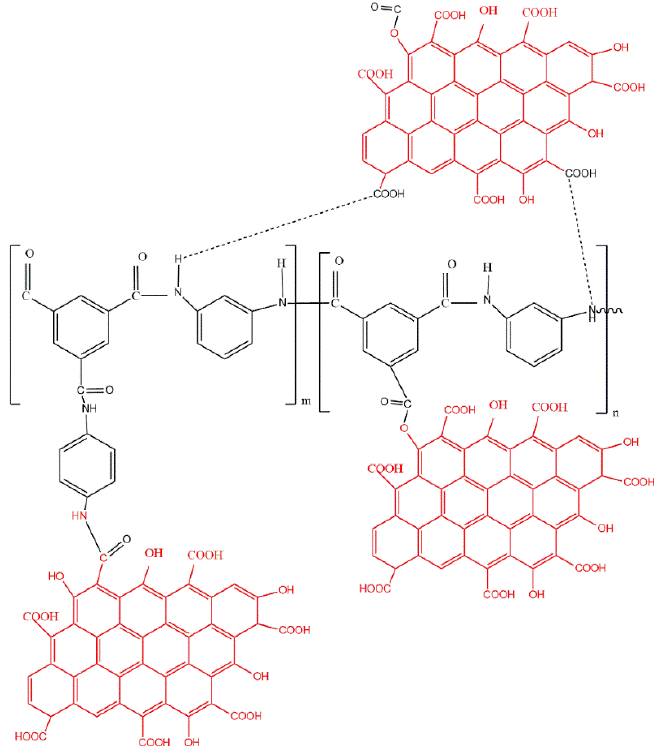
Figure 8. Interaction mechanism of PA chain and GQDs, where m and n represent the crosslinked and the linear fractions of the PA framework, respectively (m + n = 1). and the linear fractions of the PA framework, respectively (m + n =